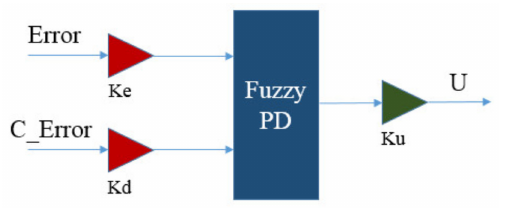
Figure 5. Fuzzy–PD